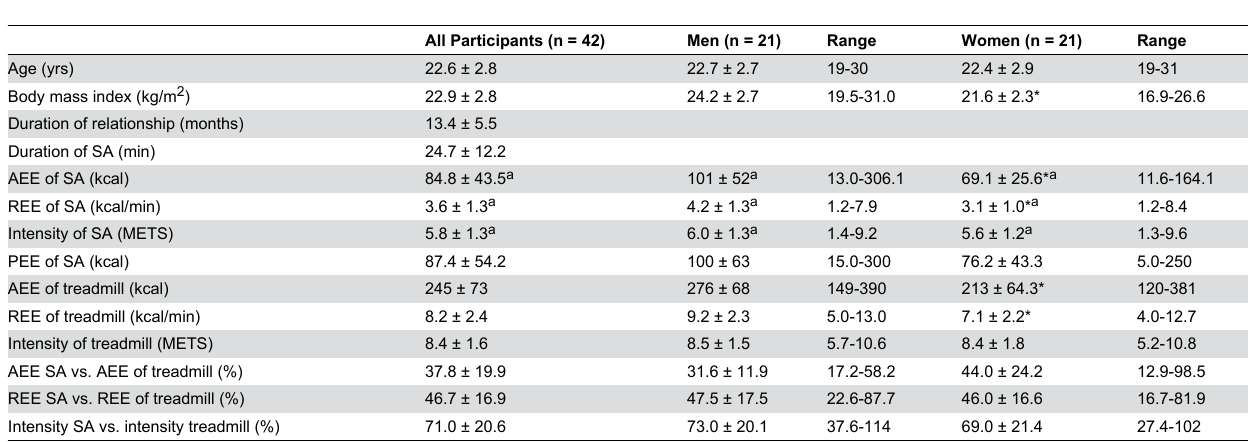
Table 1. Mean energy expenditure and intensity during sexual activity in men and